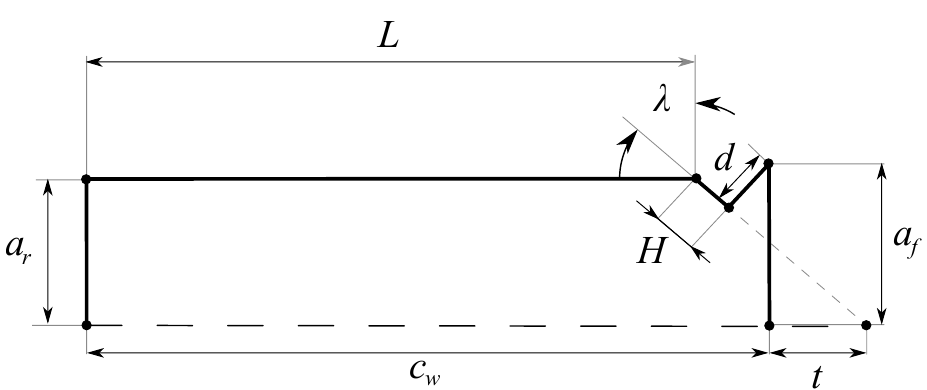
Figure 2. The simplified kinematic skeleton of the geometric model for the two-wheeled vehicle system.